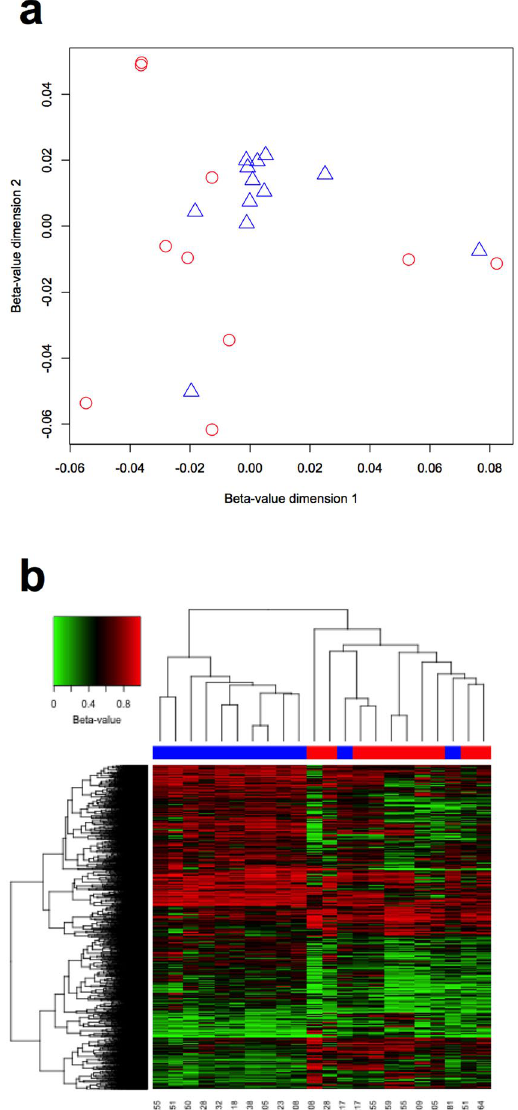
Hierarchical clustering using the 4,856 DMC for NDFs (blue) and TDFs